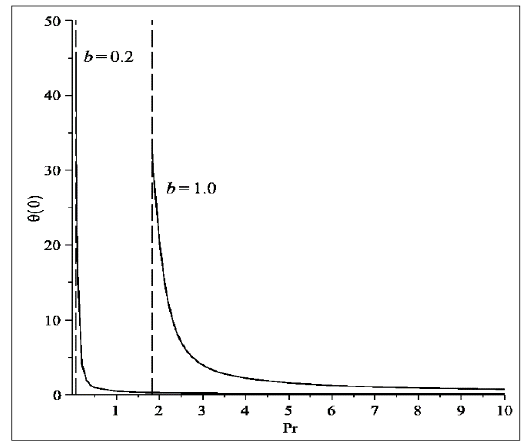
Figure 18. Various values of b on surface temperature and Pr.